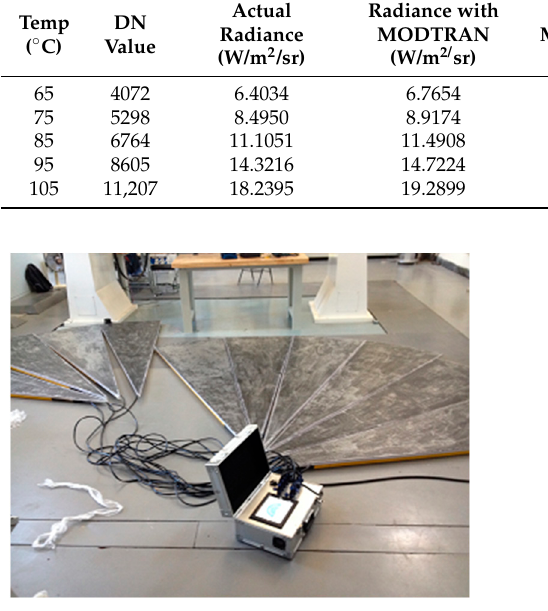
Figure 7. Heating plates used in the field test.